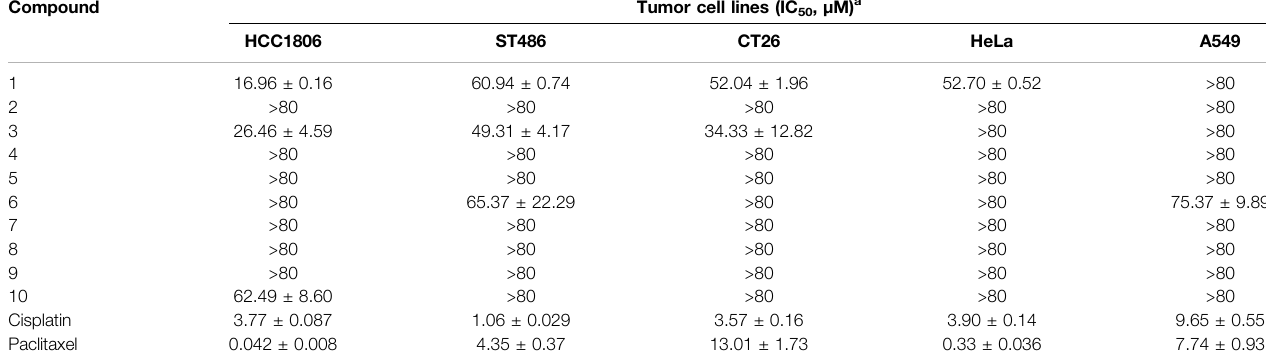
TABLE 1 | IC 50 of compounds 1 – 10 against fi ve tumor cell lines.